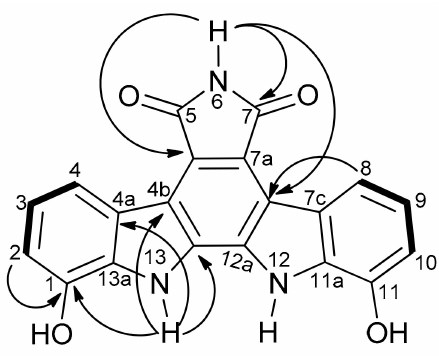
Figure 3. Structure of BE-13793C 1 with 1 H- 1 H Correlation Spectroscopy (COSY) ( — ) and key Heteronuclear Multiple Bond Correlations (HMBC) ( → ).